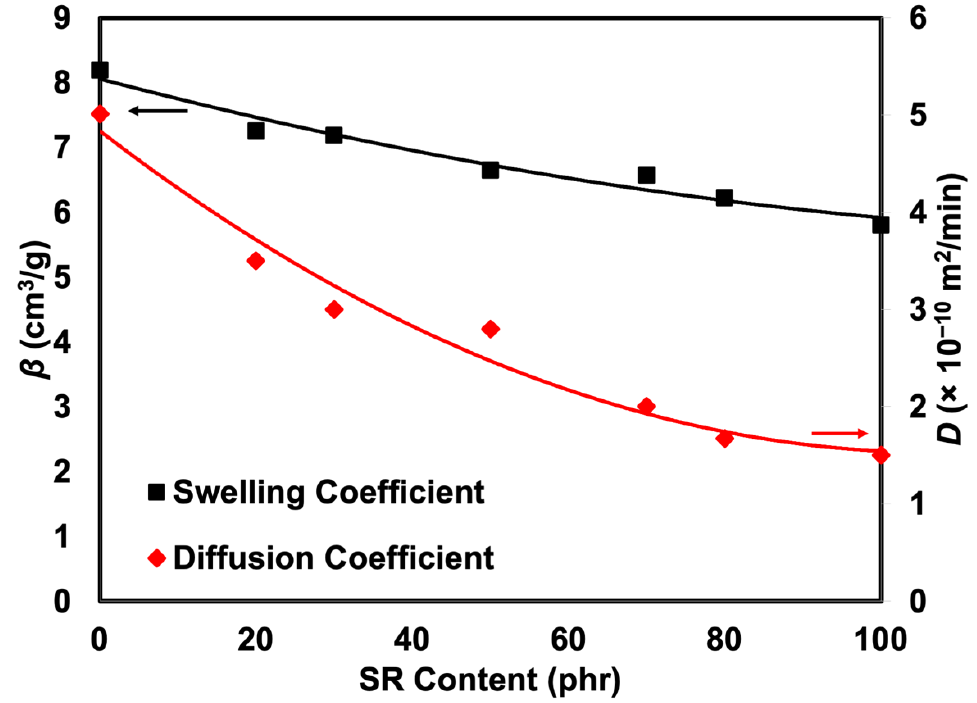
Figure 9. Swelling and diffusion coefficients of SR/NR blends.